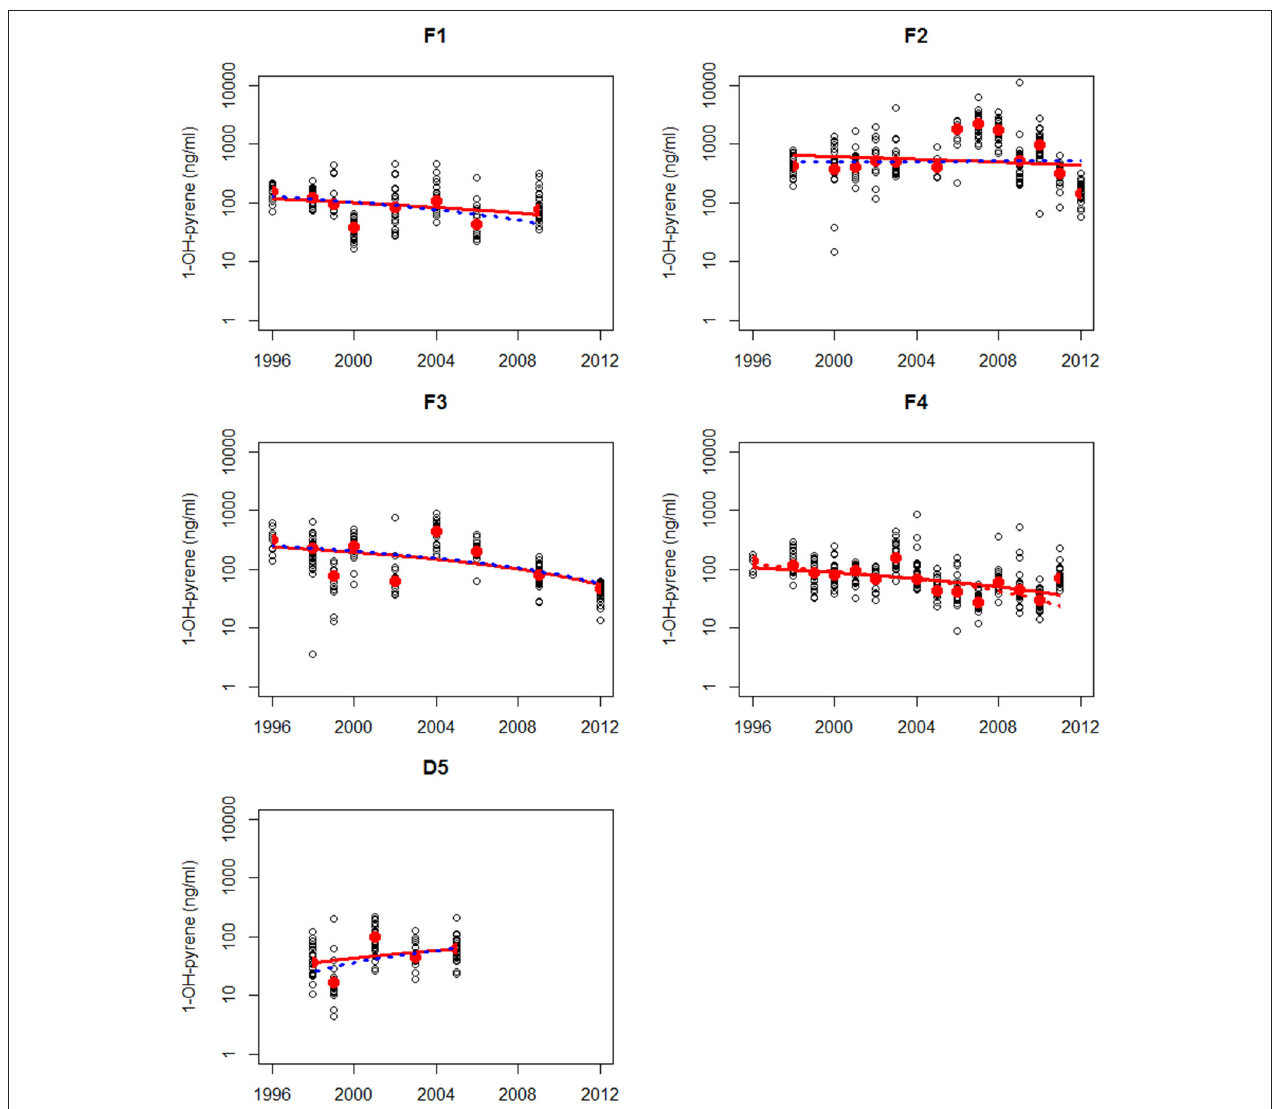
FIGURE 4 | Non-parametric trend analysis of annual medians (red dots) of 1-OH-pyrene in bile fluid of flounder on site F1 (Eastern Scheldt), F2 (Western Scheldt), F3 NZ (North Sea coast), F4 (Wadden Sea), and F5 (Ems-Dollard). Trend line shown is the Theil-Sen slope (solid line is based on all results and dotted line is based on annual medians). A statistically significant trend is indicated with a red line, otherwise the line is